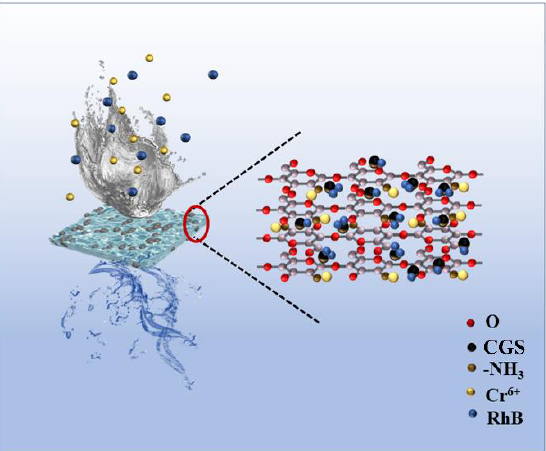
Figure 14. Schematic diagram of adsorption mechanism of RhB and Cr ( Ⅵ ) by the composite membrane.